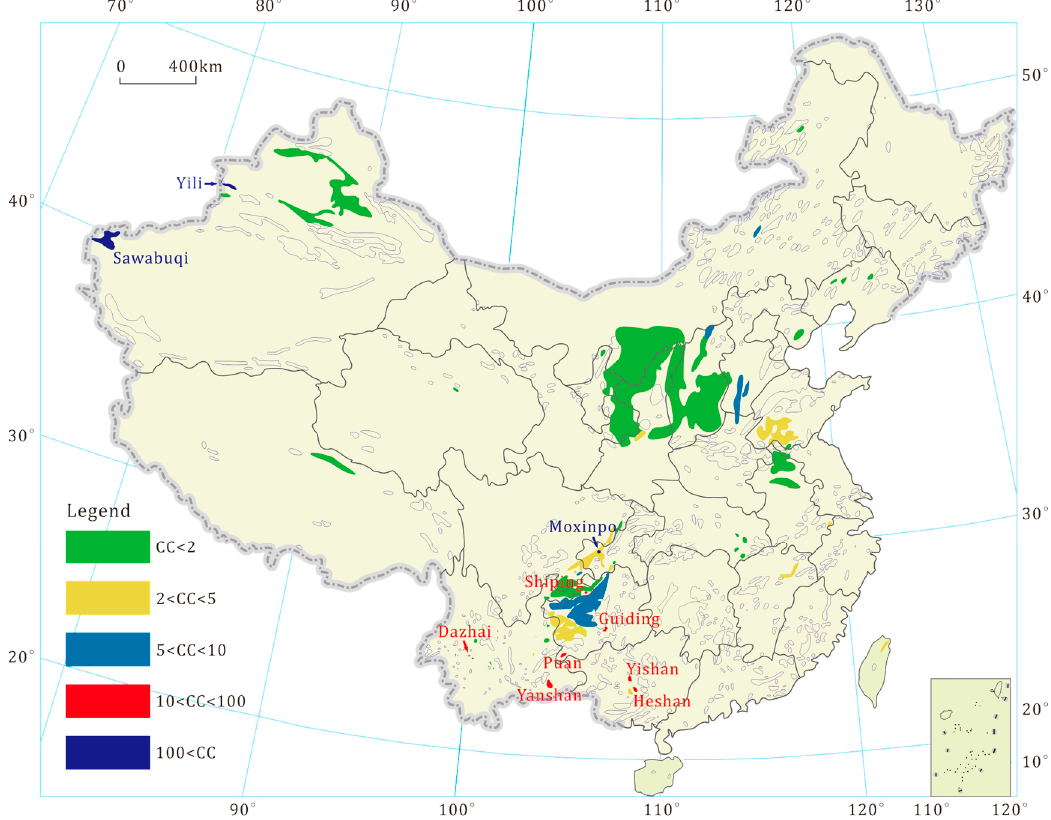
Figure 1. Distribution of uranium in different coalfields of China. Concentration coefficients (CC): ratio of uranium concentration in targeted coal to the average of common Chinese coals (2.43 mg/kg, Dai et al. [18]). Reproduced with permission from Dai et al. [50]; published by Elsevier Science, 2014.